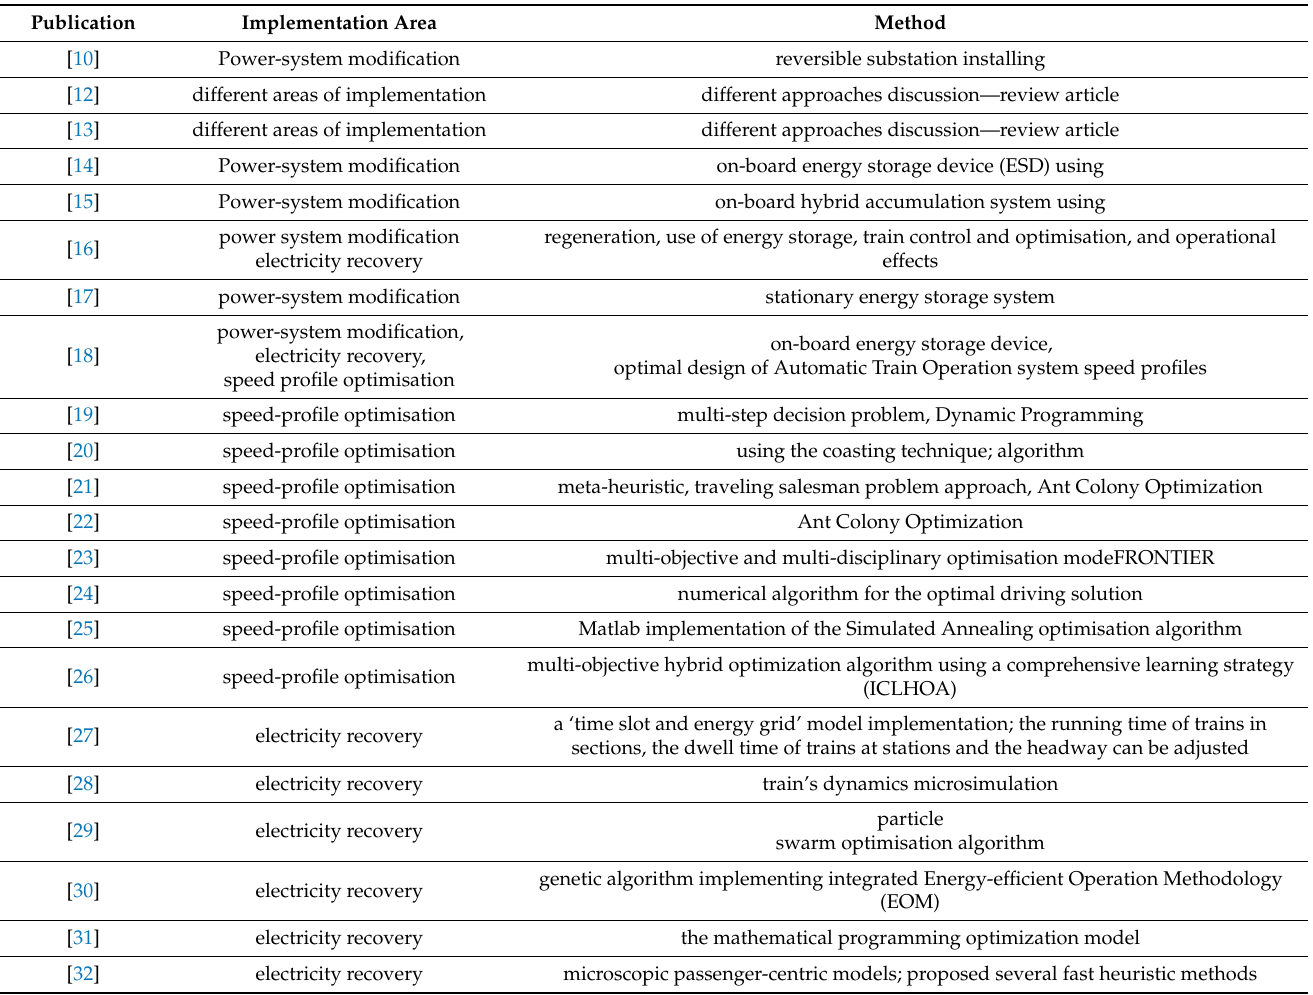
Table 1. Methods of optimising train schedules to reduce energy